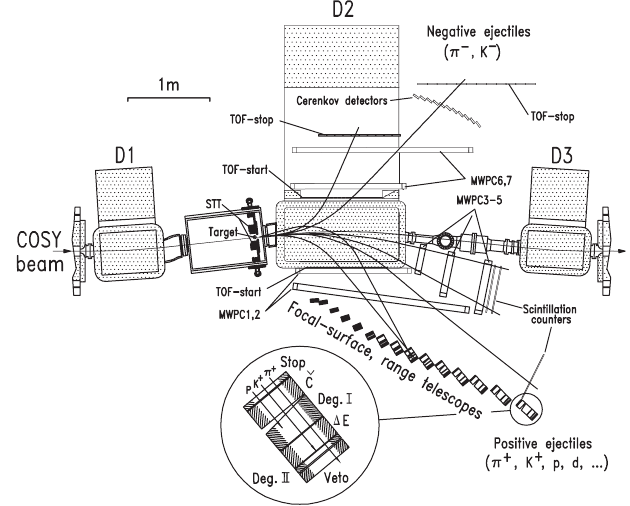
FIG. 1. Top view of the ANKE spectrometer and detectors [3,4]. The spectrometer contains three dipole magnets D1, D2, and D3, which guide the circulating COSY beam through a chicane. The central C-shaped spectrometer dipole D2, placed downstream of the target, separates the reaction products from the beam. The ANKE detection system, comprising range tele- scopes, scintillation counters, and multiwire proportional cham- bers, registers simultaneously negatively and positively charged particles and measures their momenta. The silicon tracking telescopes (STT) placed in the target chamber are used to measure low energy recoils from the